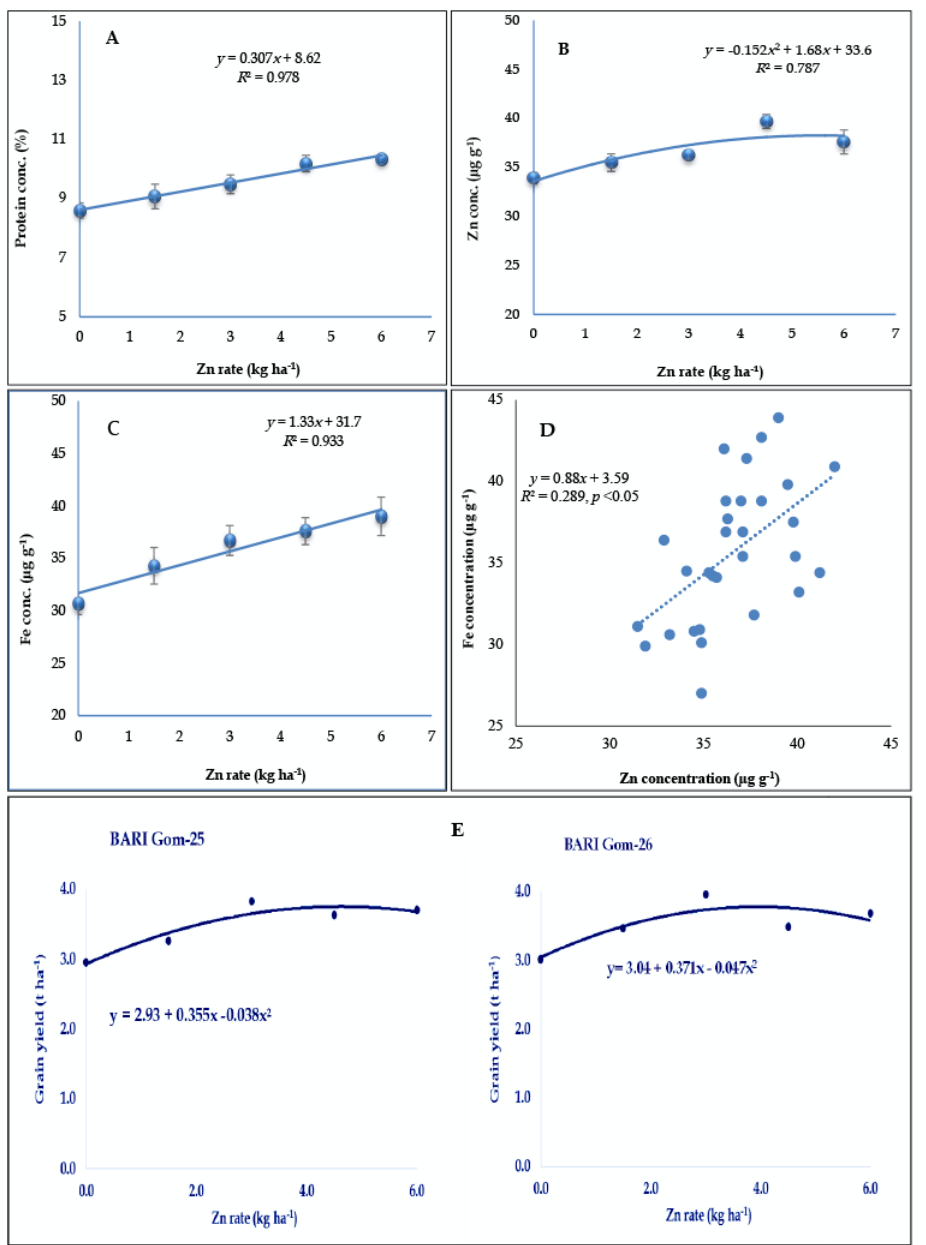
Figure 2 The influence of Zn rates on the yield and quality of wheat grains. ( A–C ) The effect of Zn application on protein, Zn, and Fe concentrations in wheat grains. ( D ) The relationship between Zn and Fe concentrations in wheat grains. ( E ) The Zn response curves of two wheat varieties under different levels of